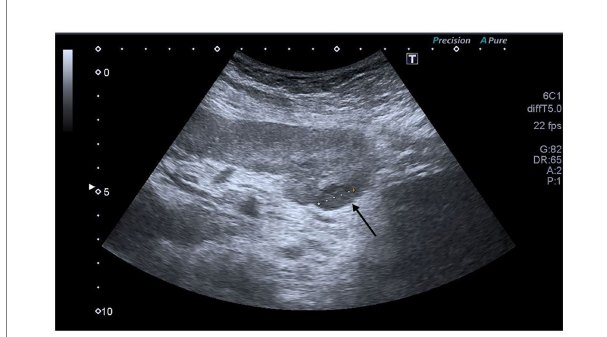
FIGURE 3 Ultrasound of the growing formation (arrow) in the kidney graft seen in the left kidney transplant recipient. An aspiration needle biopsy showed poorly differentiated cells of metastatic